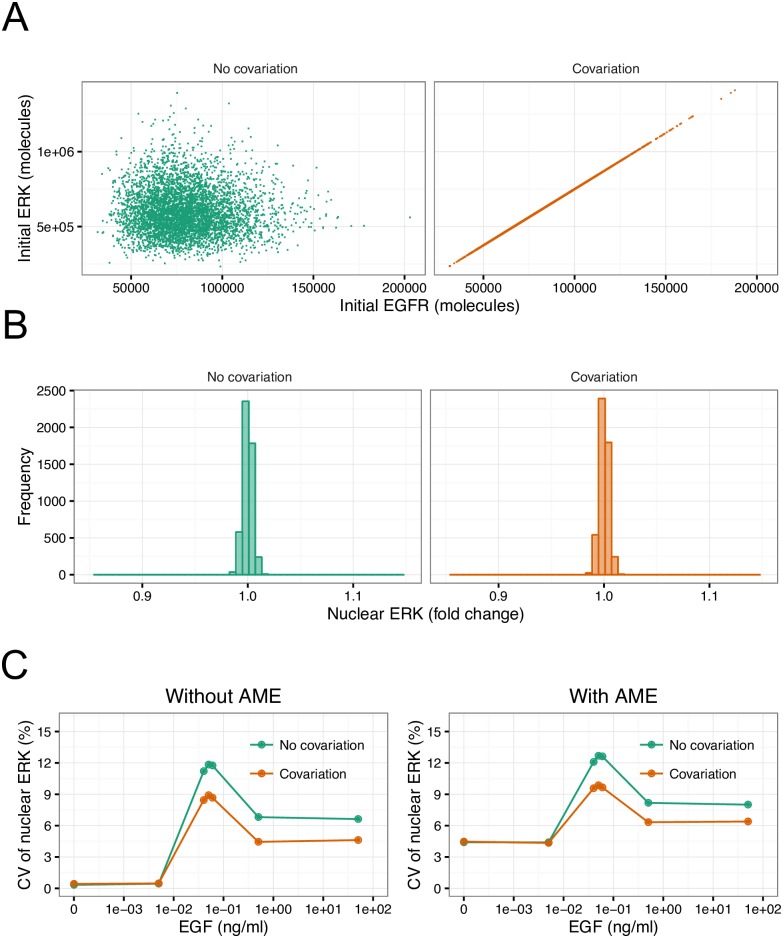
Effects of covariation among initial proteins on heterogeneity in ERK.(A) An example of the relationship among proteins under initial conditions with and without covariation. Points represent different simulation data. (B) The distributions of steady-state levels of nuclear ERK at 25% CV of initial proteins under conditions of no stimulation with and without covariation. (C) CV of peak levels of nuclear ERK with and without covariation with or without application of AME.